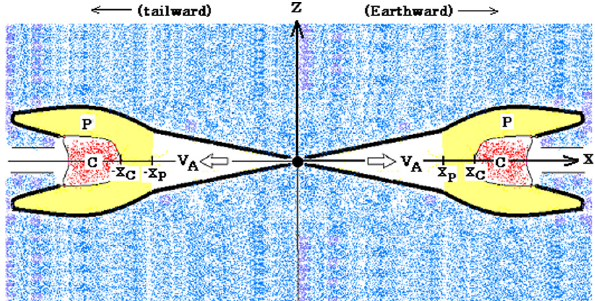
Fig. 4. Schematic drawing of a pair of plasmoids propagating in the positive and negative x-directions in the y = 0 [ (x,z) ] plane, where the overall plasmoid domain is divided into the plasmoid recon- nection region P in yellow and the plasmoid core region C in red; here, X P ( − X P ) and X C ( − X C ) indicate, respectively, the plasmoid backward end and the plasmoid center, and V A is the Alfv´en veloc-